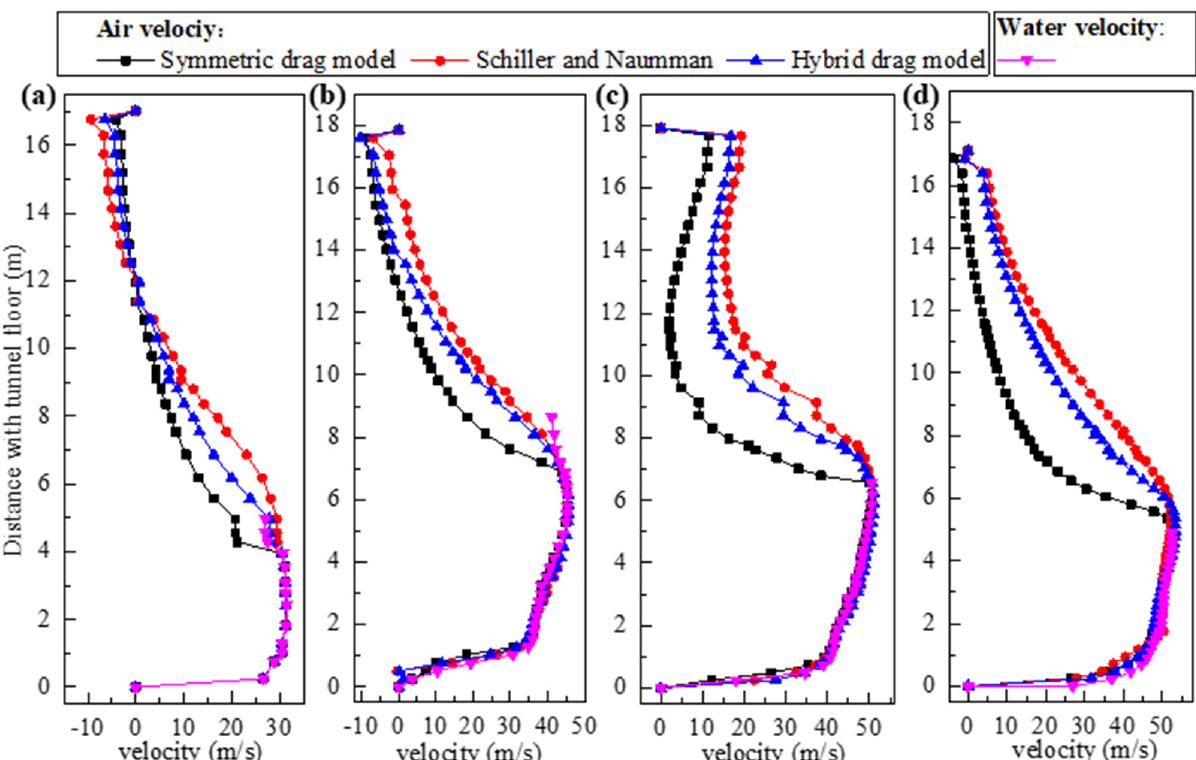
Figure 8. Water velocity and air volume fraction on the center line of typical sections (50% gate opening ratio) ( a ) downstream from the gate, section marked 0 + 773.1 m; ( b ) downstream from the